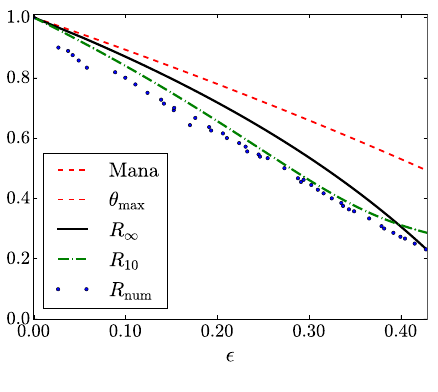
Fig. 1 Magic distillation bounds from majorization of Wigner quasi-distributions. This plot shows distillation upper bounds for qutrits obtained from majorization on unital protocols. The constraints are plotted as a function of the depolarizing error ϵ for a noisy Strange state (Eq. 23). The bound R ∞ follows from a Lorenz curve analysis presented before Eq. 32, while the bound R 10 comes from single-shot entropies on the Wigner quasi-distributions, as discussed in the derivation of Eq. 52. Numerical bounds R num are obtained by using the full set of majorization constraints. Bounds R ∞ , R 10 , R num all provide stricter constraints than mana 101 and max – thauma θ max 116 bounds for noisy Strange states.